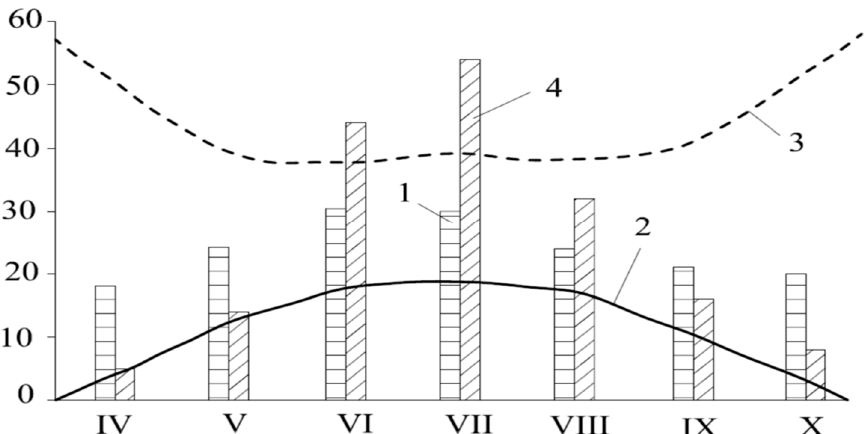
Figure 1. Long-term climatic data of the Pavlodar weather station (1930–2022) average monthly data: 1—precipitation, mm; 2—air temperature, C; 3—relative humidity at 13 h, 4—water consumption of wheat.